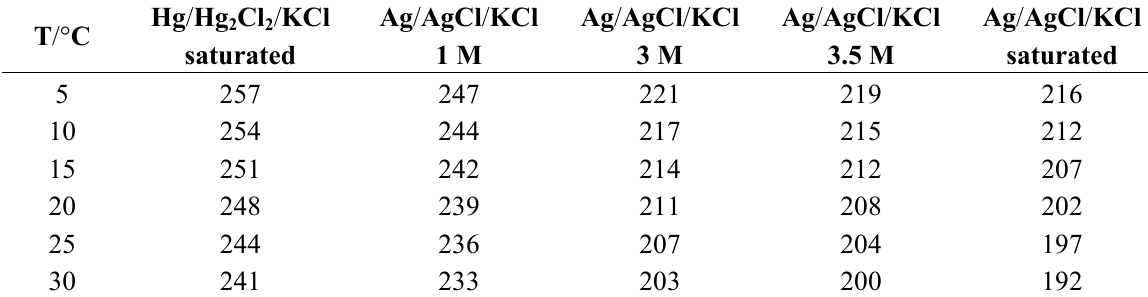
Table 1. E constant (mV) that should be added to the measured redox potential E B according to the reference electrode in order to get a value referenced relative to a normal hydrogen